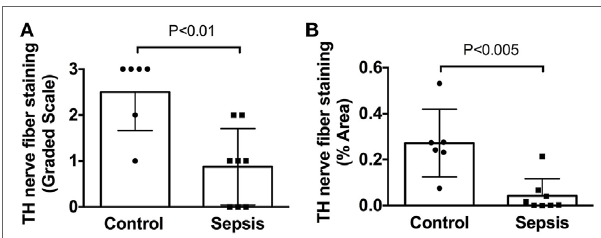
FigUre 5 | Quantification of tyrosine hydroxylase (TH) nerve fiber staining shows a significant deficit in spleens from patients with end stage sepsis. (a) Semi-quantitative evaluation of TH nerve fiber abundance was performed using a grading scale ranging from 0 to 3 as described in Section “Materials and Methods.” (b) Quantitative evaluation of TH nerve fiber abundance was performed, as described in Section “Materials and Methods,” using ImageJ to measure the % area occupied by TH + nerve fibers. Both methods showed a significant reduction of TH + nerve fibers in spleen samples from septic patients compared to control patients. Data in panel (a) were evaluated using a two-tailed Mann–Whitney test for unpaired samples ( n = 6 for control and n = 8 for septic; P = 0.0077). Data in panel (b) were evaluated using a two-tailed t -test for unpaired samples ( P = 0.0024). Values are mean ±